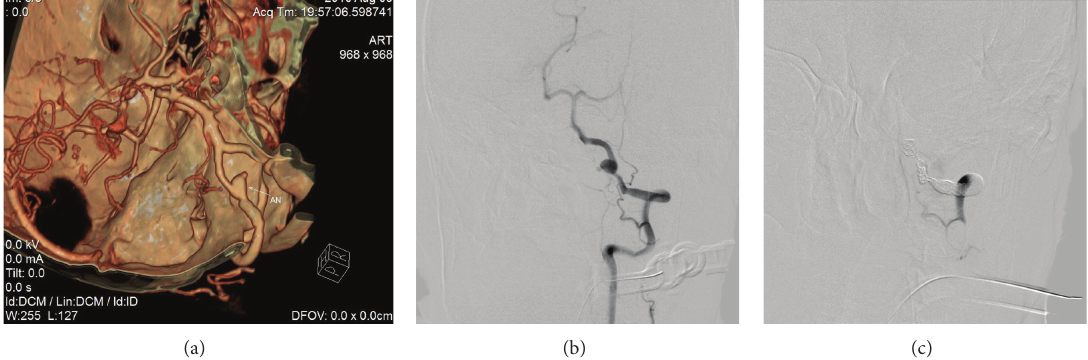
Figure 1: A 56-year-old hypertensive and smoker male patient presented with acute onset headache and loss of consciousness. Brain CT angiography revealed dissecting aneurysm in the distal segment of left vertebral artery. (a) This finding was confirmed by DSA. (b) The patient underwent coil embolization and parent artery occlusion. (c) Unfortunately, the patient died because of aspiration pneumonia 10 days